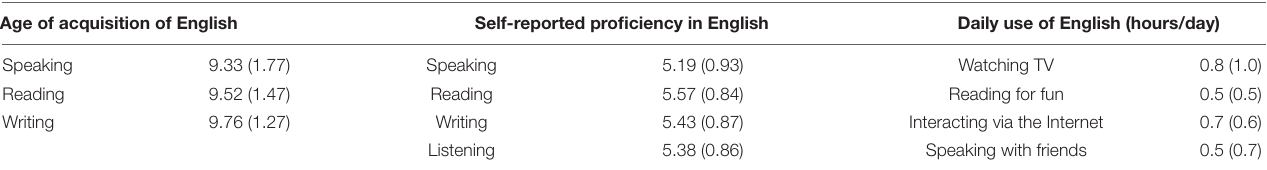
TABLE 2 | Linguistic information for the participants (Language History Questionnaire—LHQ; Li et al., 2014): self-reported information on the Age of acquisition of communicative competencies in English; Self-reported proficiency (1–7 scale), and daily time (in hours) spent using English. Age of acquisition of English Self-reported proficiency in English